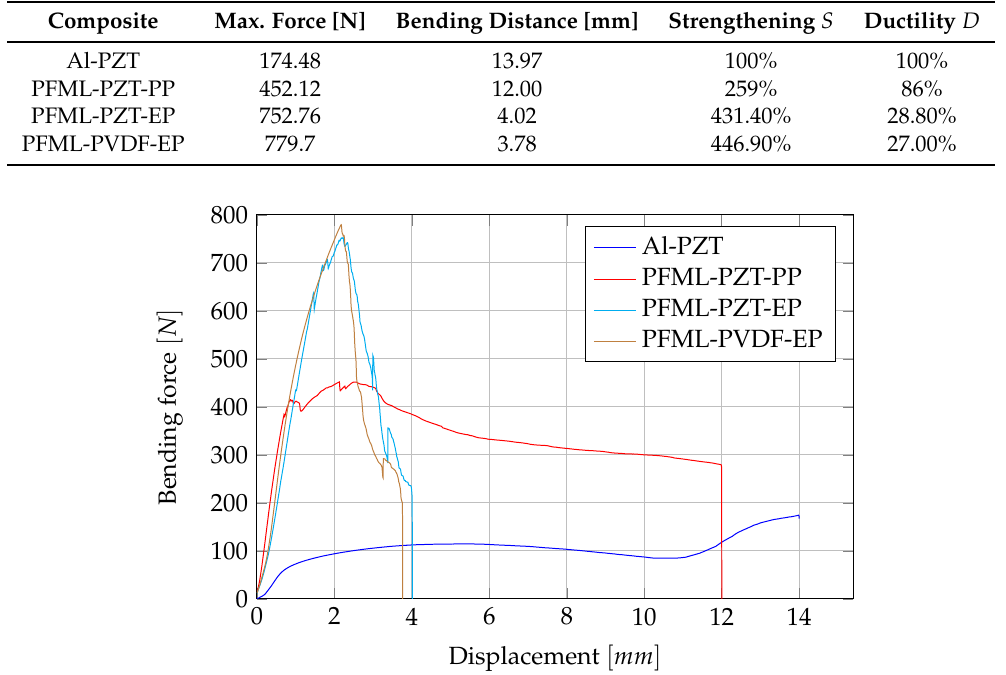
Table 1. Summary of the results from the static three-point bending tests for the thermoplastic composites.